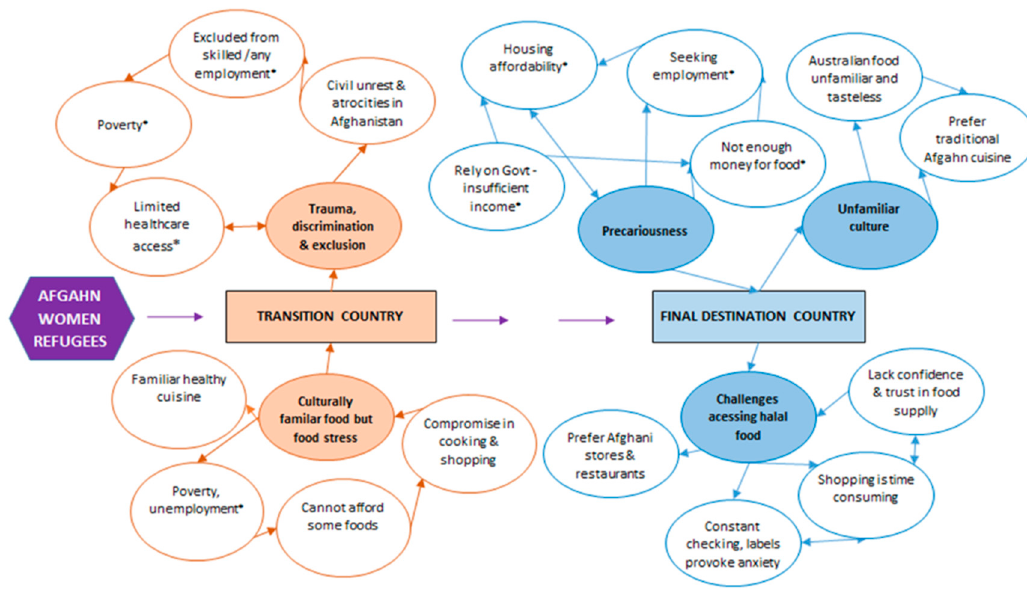
Figure 1. Themes and subthemes of Afghani women’s experiences of migration, food and stress during the migration journey from transition to final destination country. Key: solid orange circles = main themes in transition countries (Iran or Pakistan), white circles with orange borders = subthemes. solid blue circles = main themes in destination country (Australia), white circles with blue borders = subthemes. Uni-directional arrows are used to indicate a subtheme which has arisen from a main or parent theme. Bi-directional arrows are used to show an inter-relationship between subthemes. Sub-themes with an asterisk reflect a key social determinant of health which may influence individual or community health.